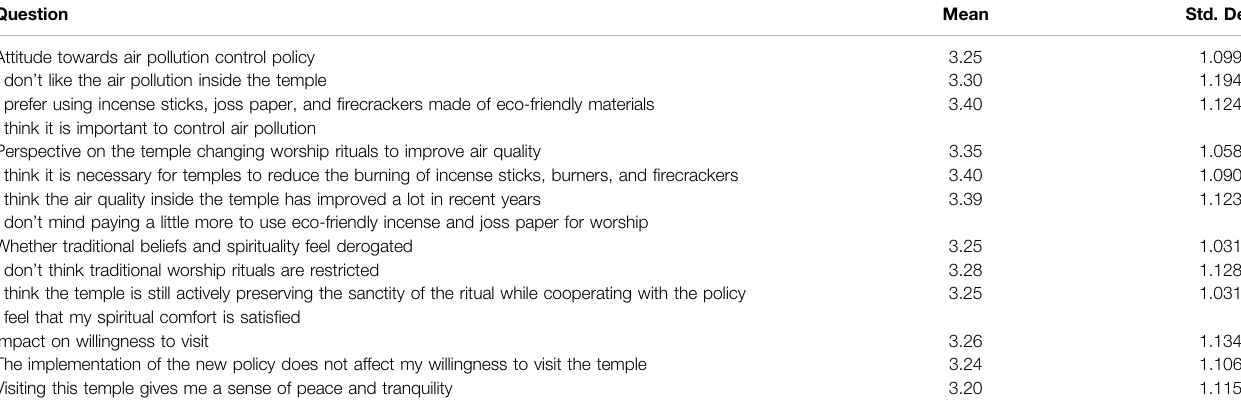
TABLE 2 | Respondents ’ opinion of the temple new air control pollution policy implementation.